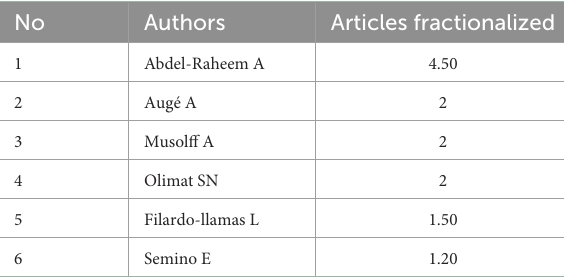
TABLE 2 Top ten most influential journals in metaphor and discourse on